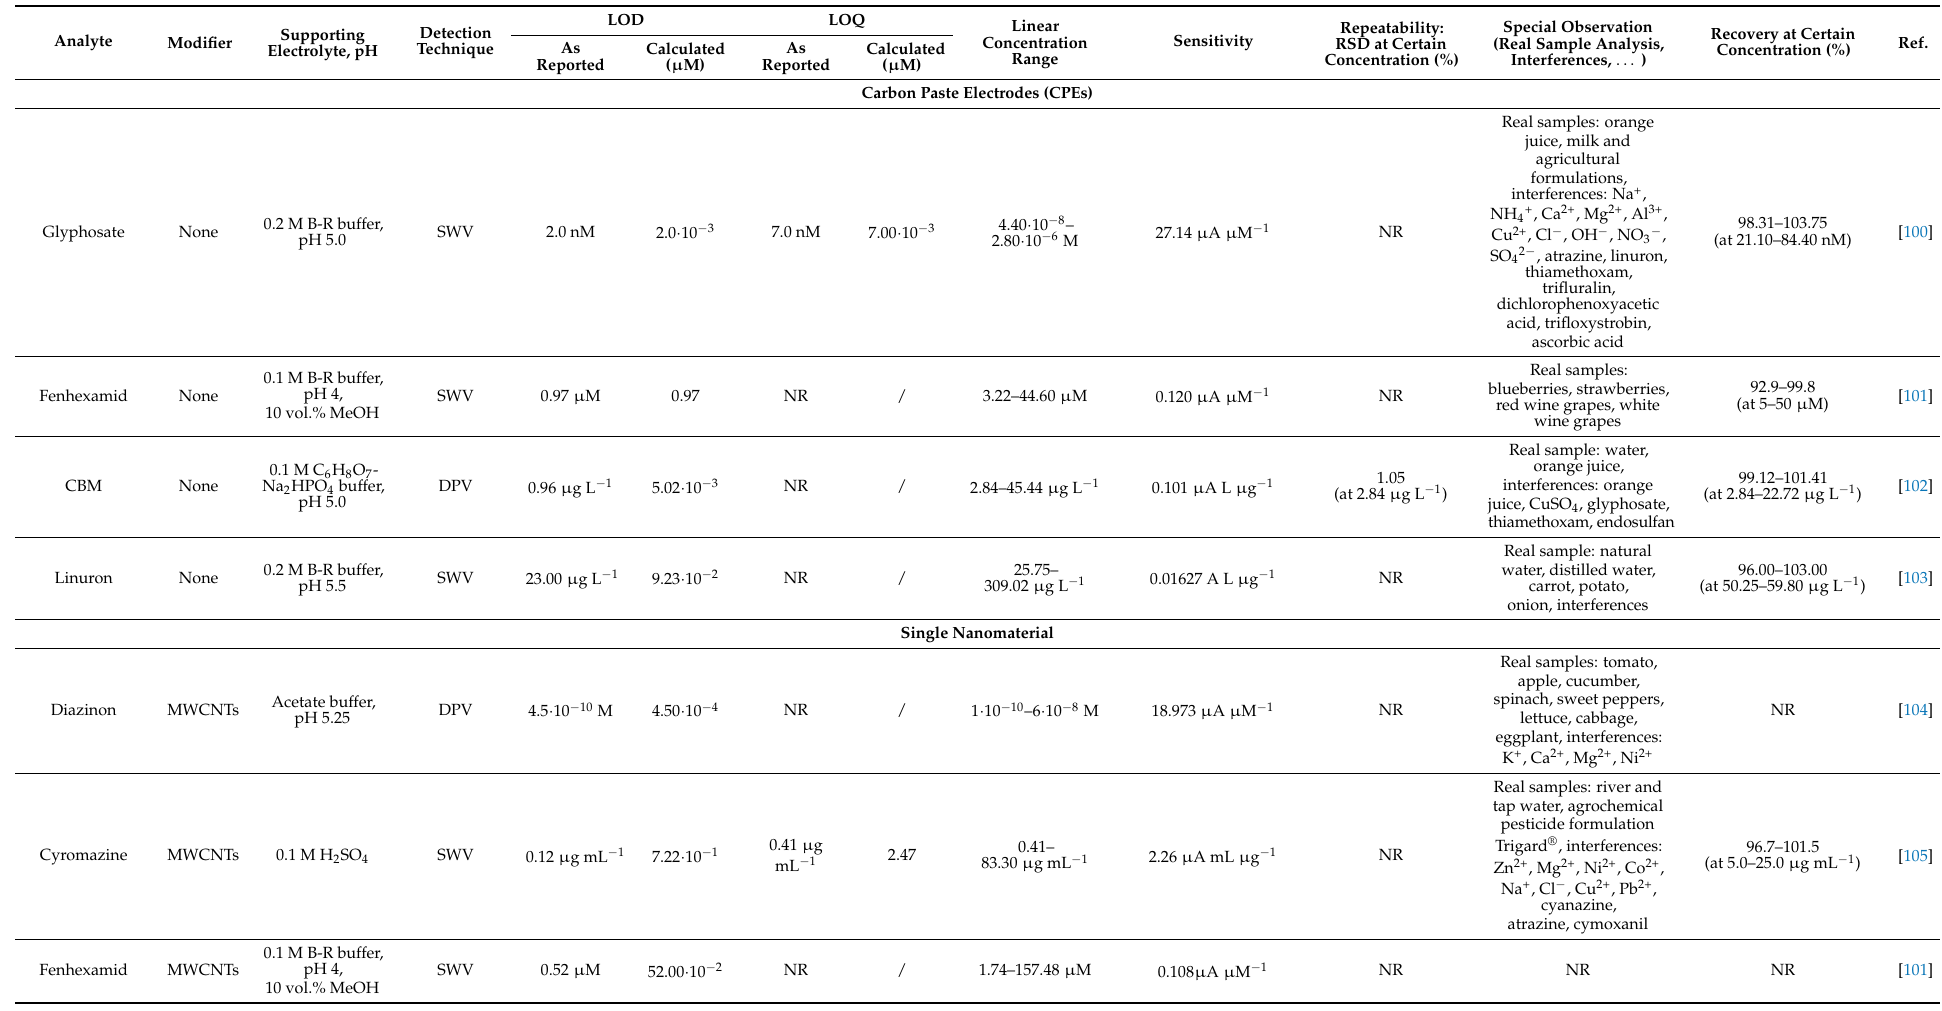
Table 2. Data of recently reported electrochemical sensors for non-enzymatic pesticide detection using modified carbon paste electrodes (CPEs).